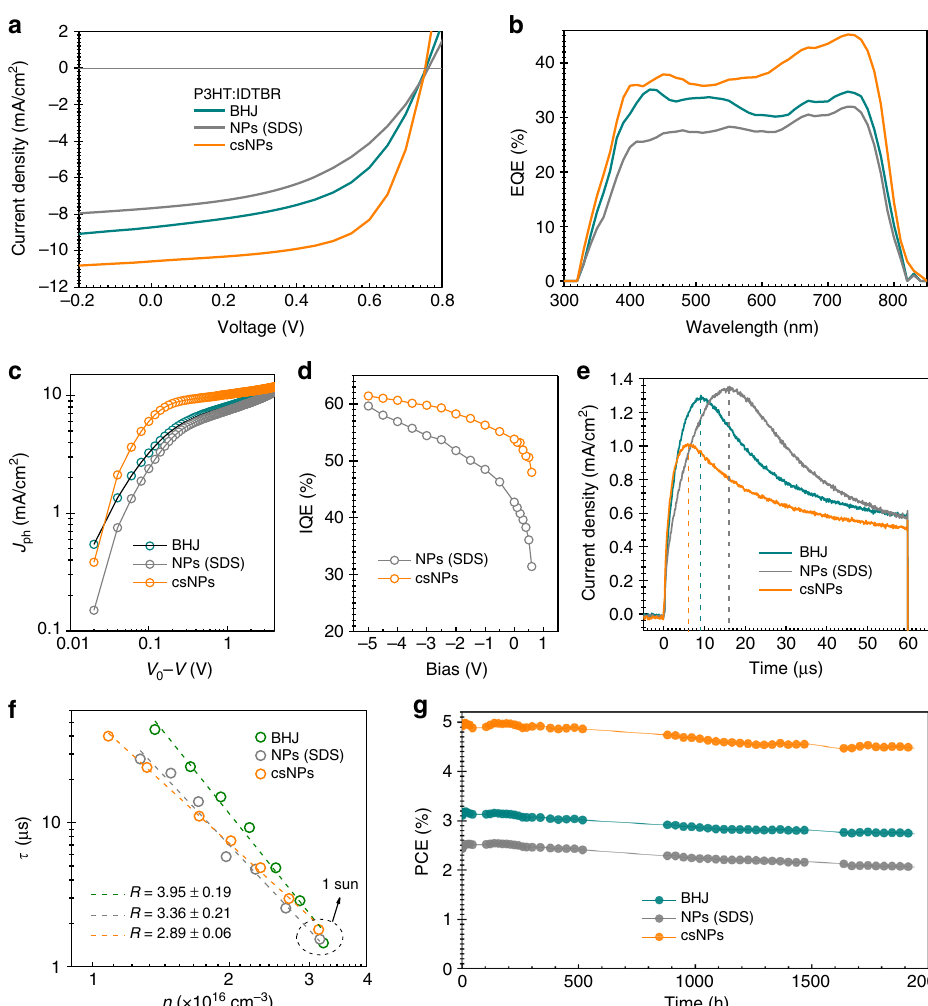
Fig. 4 Device characteristics and stability of cs-NP-based organic solar cells. a Light current – voltage, b EQE, c photocurrent as function of effective voltage, d IQE values at wavelength of 730 nm as function of applied bias, e Photo-CELIV traces after a delay time of 1 µ s, f Charge carrier lifetime τ , obtained from TPV, as function of charge density n , calculated from CE measurements under V OC conditions and g PCE in the course of 2000h light exposure with UV fi lter in N 2 atmosphere of P3HT:IDTBR-based solar cells processed by BHJ THF solution, water dispersion with NPs (SDS) and water dispersion with cs- NPs. Device architecture: glass/ITO/ZnO/active layer/MoO x /Ag